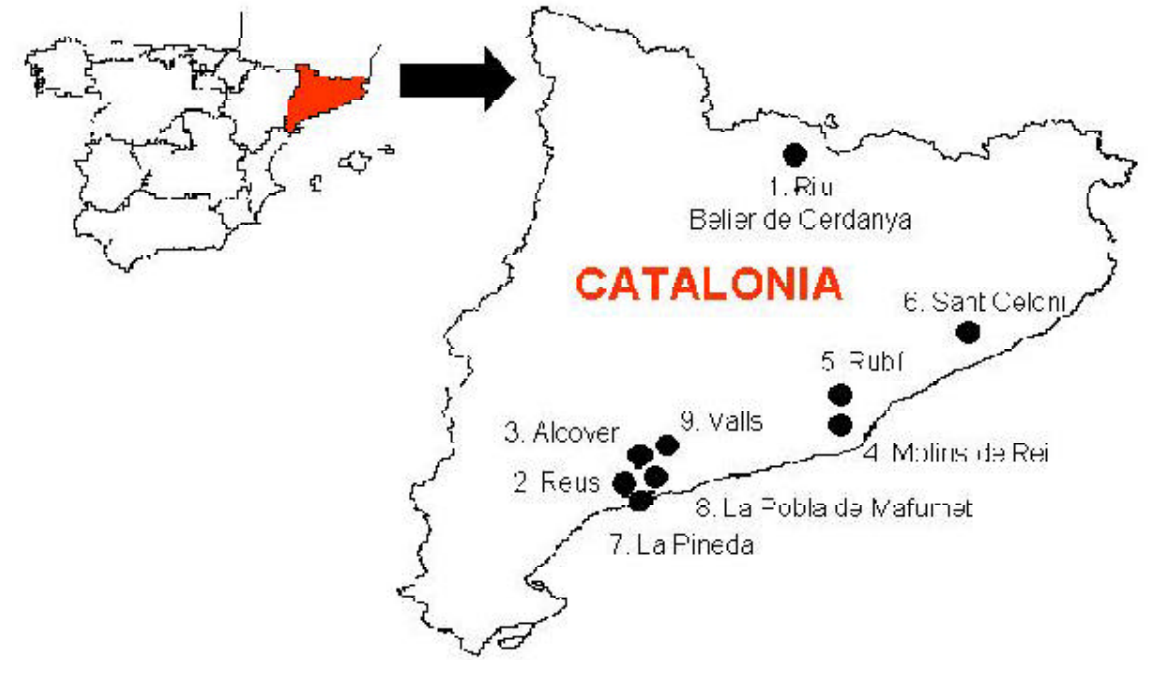
FIGURE 1. Map with sampling locations in Catalonia,